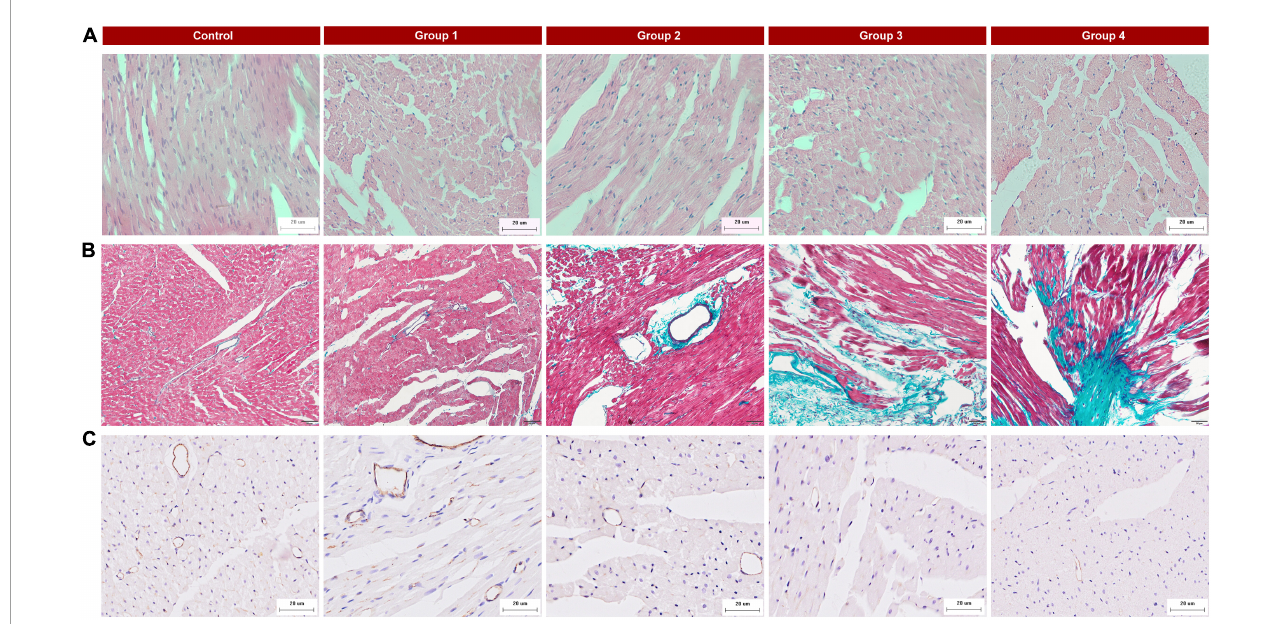
FIGURE4 Typical histopathologic findings in the five groups. (A) Hematoxylin and eosin (HE) staining ( × 400): there were obvious vacuolar changes in the myocytes in the DOX treated group; (B) Masson’s trichrome staining ( × 200): myocardial interstitial fibrosis gradually increased and perivascular fibrosis worsened with the progression of DOX treatment; (C) CD31 staining ( × 400): reduced microvessel numbers in the DOX groups compared with the control.